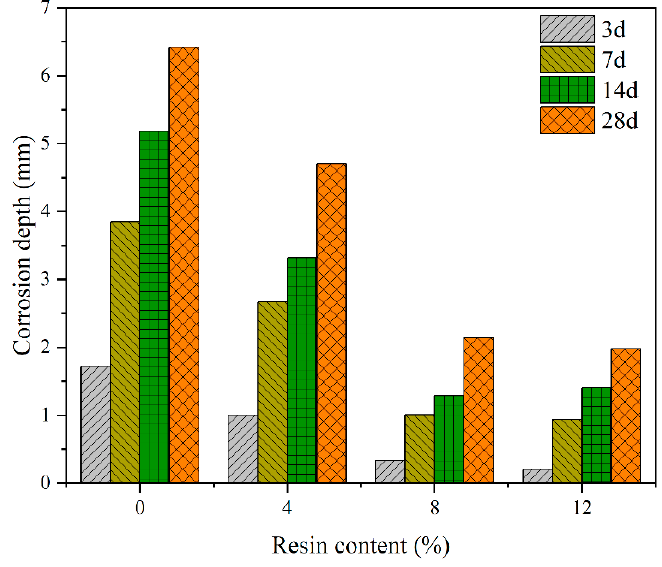
Figure 4. Corrosion depth versus resin content.